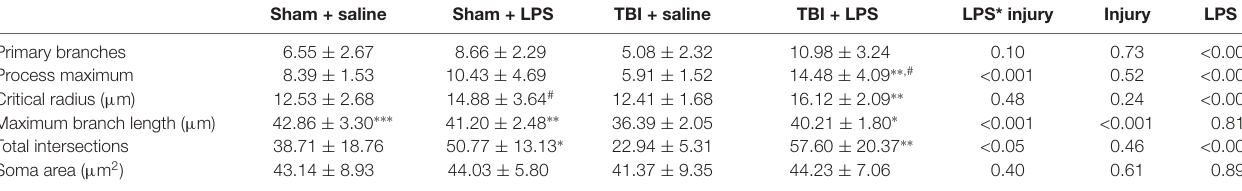
Sham + saline Sham + LPS